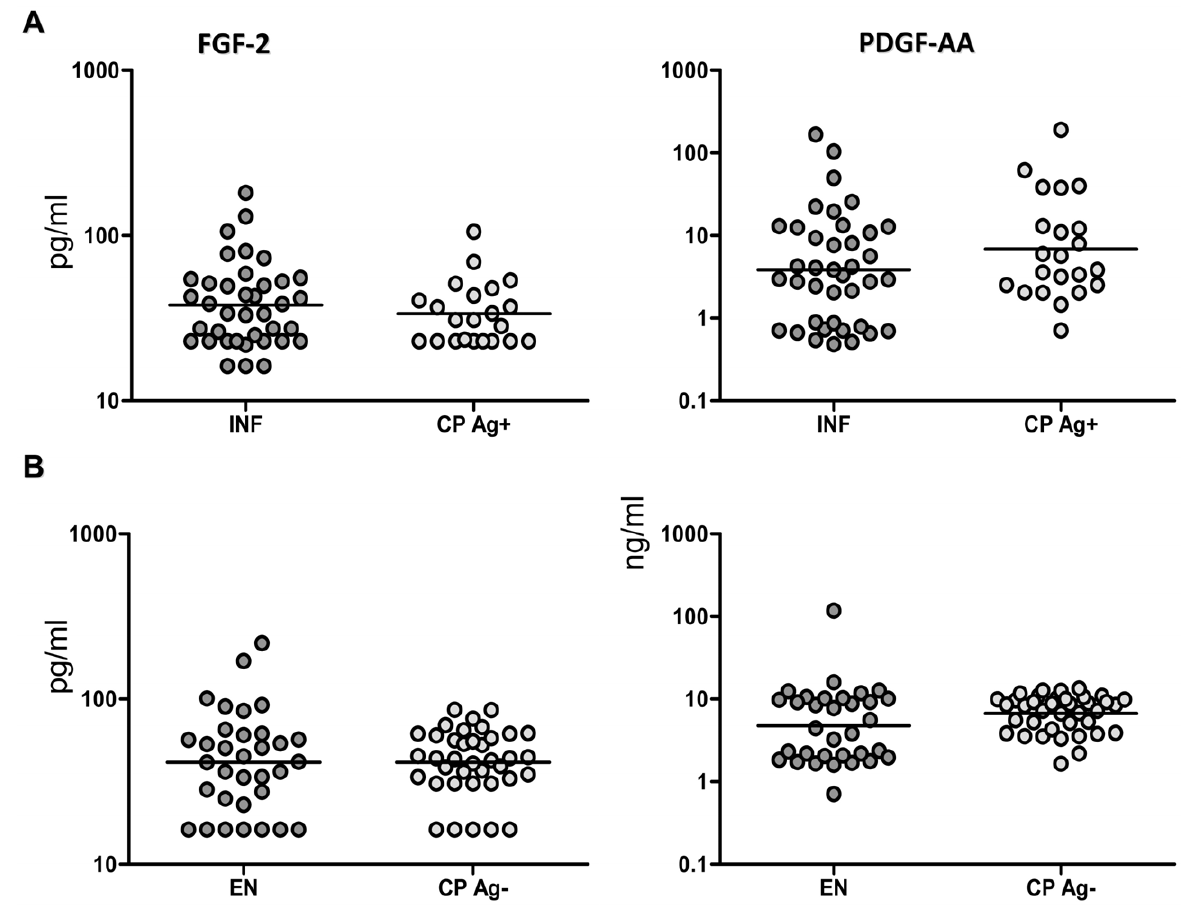
Figure 4. Filarial lymphedema is not associated with elevated levels of FGF-2 or PDGF-AA. (A) Plasma levels of FGF-2 and PDGF-AA from filarial lymphedema individuals with active infection [CP Ag + ] ( n =21–22) and asymptomatic infected [INF] (n=22–39) individuals were measured by ELISA. (B) Plasma levels of FGF-2 and PDGF-AA from filarial lymphedema individuals without active infection [CP Ag 2 ] (n=22–38) and endemic normal [EN] (n=21–33) individuals were measured by ELISA. P values were calculated using the Mann-Whitney test.